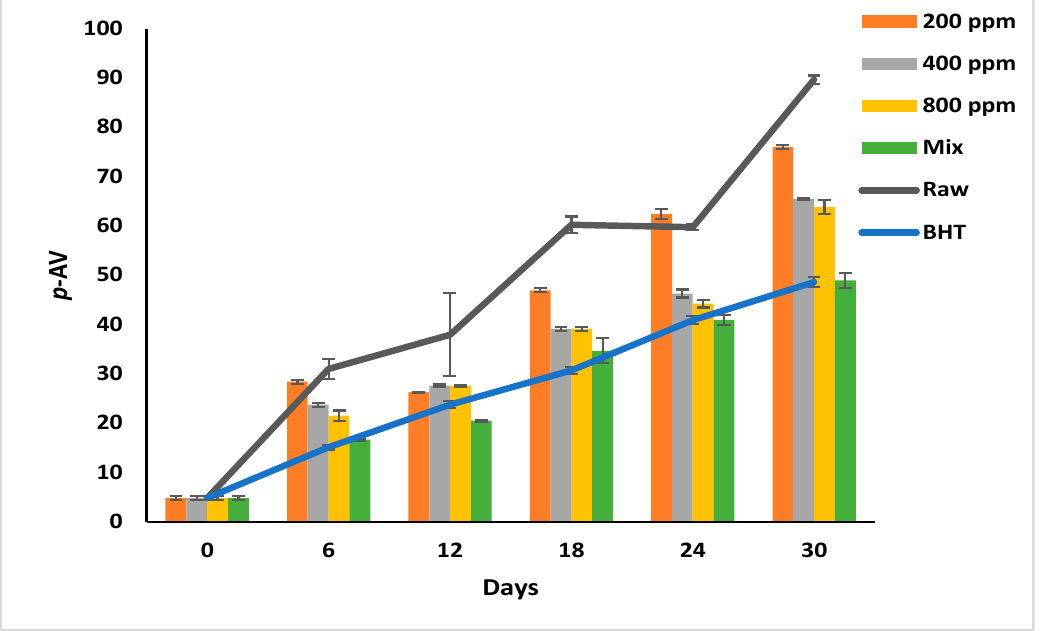
Figure 4. P -Anisidine value ( p- AV) of raw soybean oil (without antioxidants) and soybean oil enriched with PGG leaves extract (200, 400, and 800 ppm), BHT (200 ppm), and a PGG/BHT mixture (400/100 ppm) during the accelerated storage days (30 days) at 65 °C.